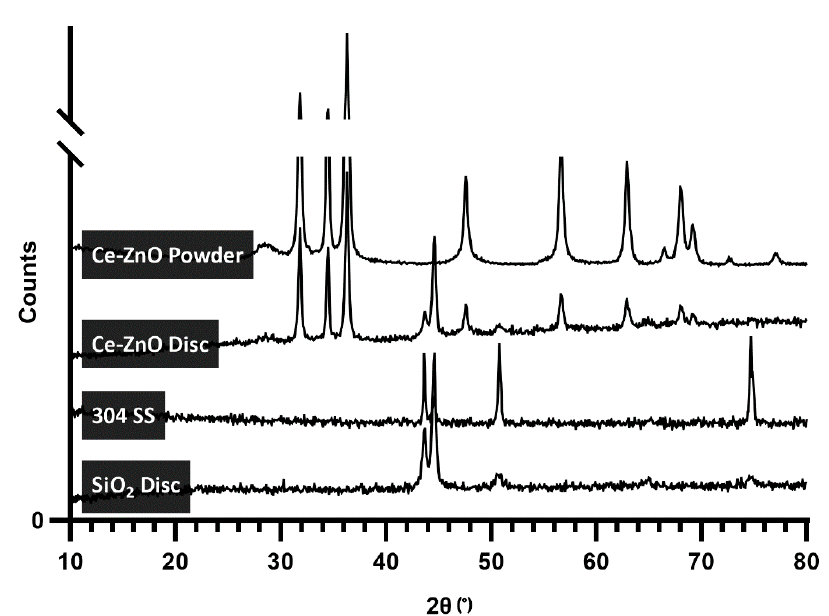
Figure 2. XRD patterns of SiO 2 disc, 304SS (bare metal disc), Ce-ZnO disc and Ce-ZnO powder.